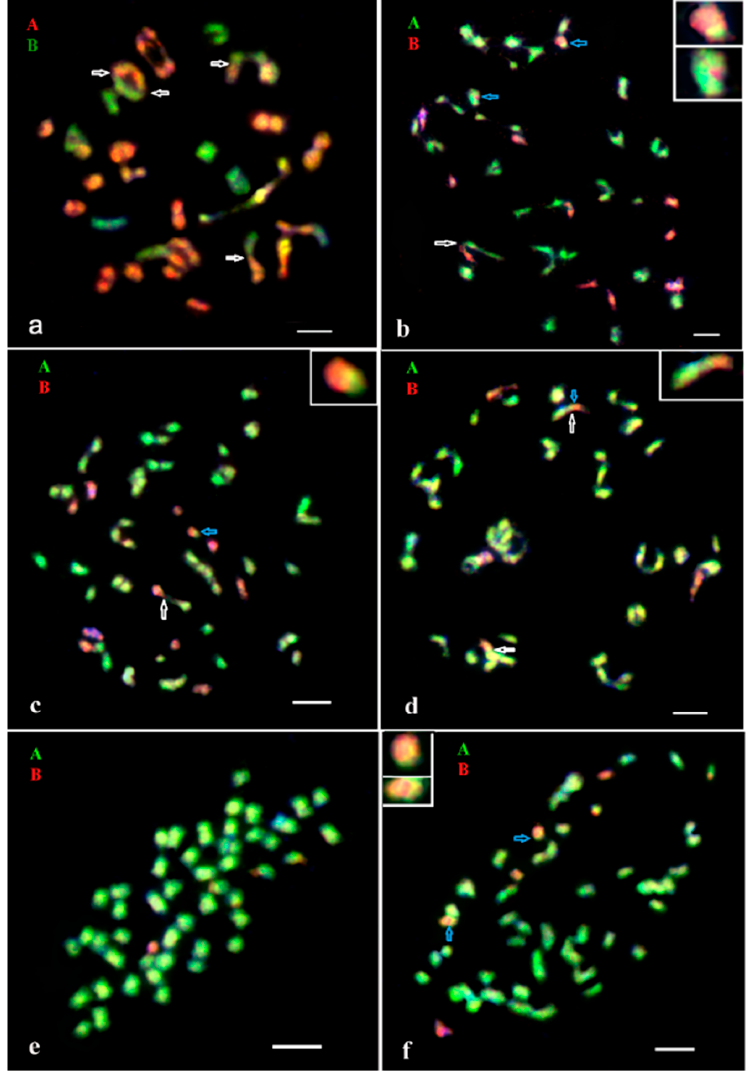
Figure 2. GISH analysis of chromosome content and homeologous pairing in hybrids of different generations. ( a ) Diakinesis in PMC of F 1 (chromosome doubling) hybrid IGC 15/118.3.C6.2016: 48 chromosomes of the A genome and 24 chromosomes of the B subgenome of S. stoloniferum , three intergenomic chromosome associations were identified (2 IV A/A/B/B and 1 II A/B). ( b ) Diakinesis in PMC of BC 1 hybrid IGC 16/38.16: 48 chromosomes of the A genome (one of them with the B subgenome introgression) and 12 chromosomes of the B subgenome (one of them with the A genome introgression), A/A/B trivalent is detected. ( c ) Diakinesis in PMC of BC 1 hybrid IGC 17/192.4: 48 chromosomes of the A genome and 12 chromosomes of the B subgenome (one of them with the A genome introgression), A/B rod bivalent is observed. ( d ) Diakinesis in PMC of BC 2 hybrid IGC 17/170.30: 48 chromosomes of the A genome and five chromosomes of the B subgenome (one of them with the A genome introgression), two A/B rod bivalents are observed. ( e ) Somatic chromosomes of BC 2 hybrid IGC 19/323.17 hybrid: 48 chromosomes of the A genome and one chromosome of the B subgenome of S. stoloniferum . ( f ) Somatic chromosomes of BC 2 hybrid IGC 19/305.5: 48 chromosomes of the A genome and six chromosomes of the B subgenome (one of them with the A genome introgression). The color of the fluorescence of the B subgenome (labeled DNA probe of S. jamesii ) and the A genome (DNA probe of S. verrucosum ) corresponds to the color of the letters above the images. Blue arrows show recombinant chromosomes. Homeologous pairing between the A genome chromosomes and the B subgenome chromosomes are indicated by white arrows. Scale bar = 5 µ